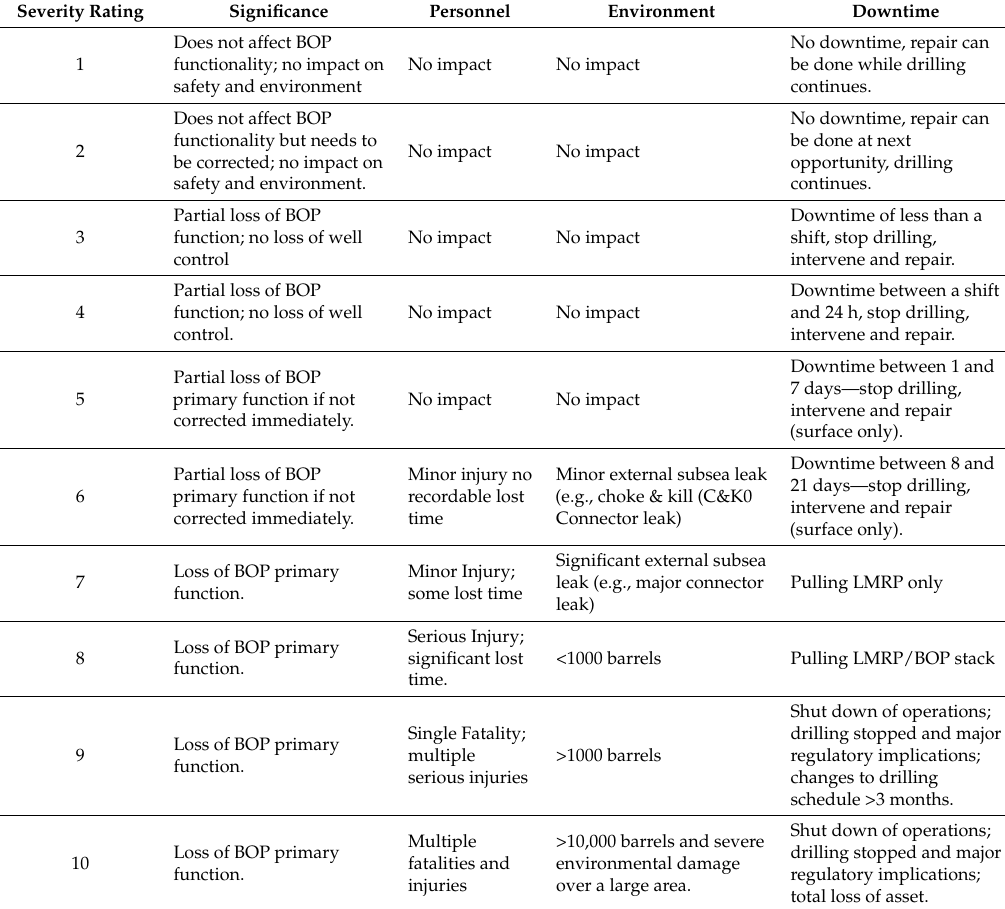
Table 4. Severity ratings of a failure for BOP.